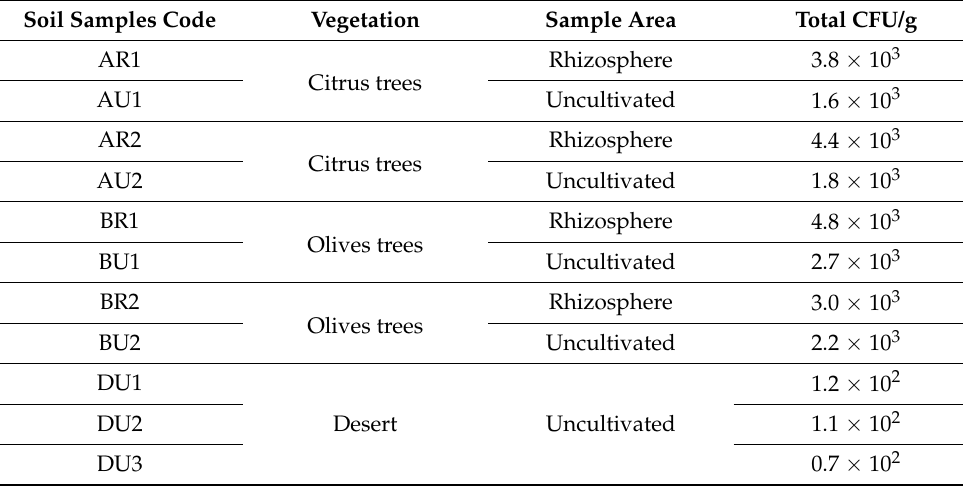
Table 2. A list of the successfully obtained fungi expressed as CFU/g from each sample. Soil Samples Code Vegetation Sample Area Total